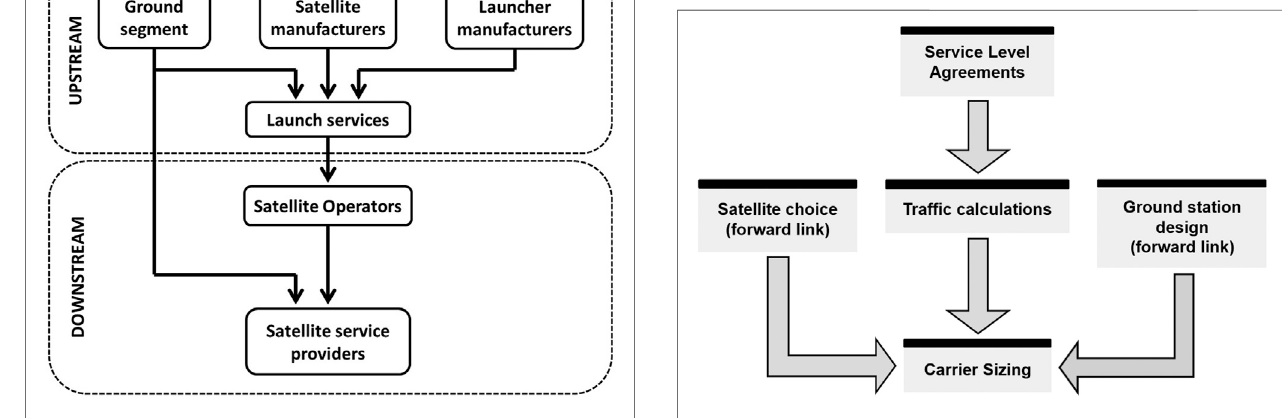
FIGURE 1 | Satellite industry value chain. FIGURE 2 | Inputs of the return link carrier sizing